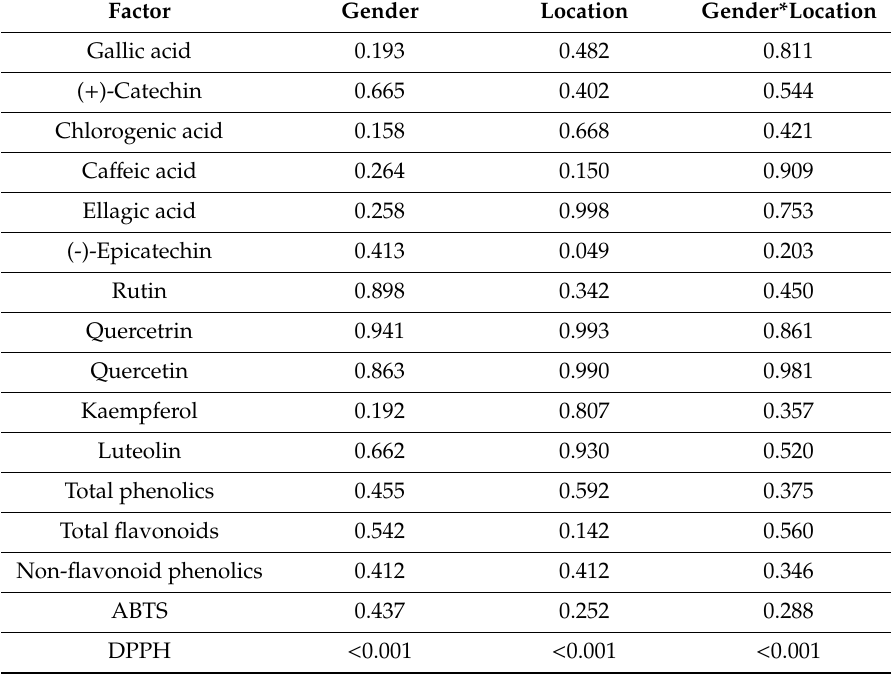
Table 4. Two-way ANOVA to check for di ff erences between gender and location and the interaction between these factors on the phenolic composition and antiradical activity of B. myriocephala and B. trimera